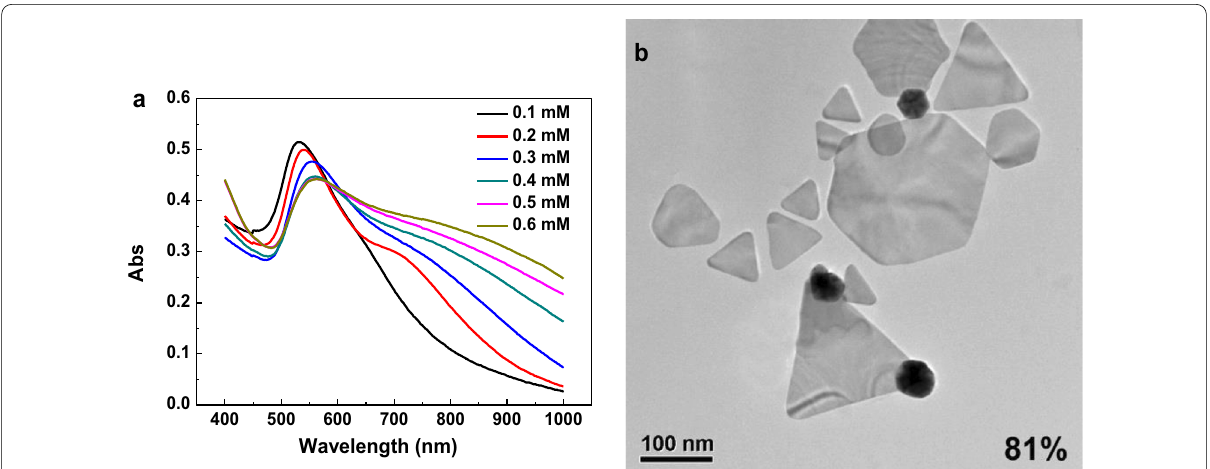
Fig. 8 Preparation of GNPs with sodium oxalate as protective agent: a UV–Vis spectra; b TEM